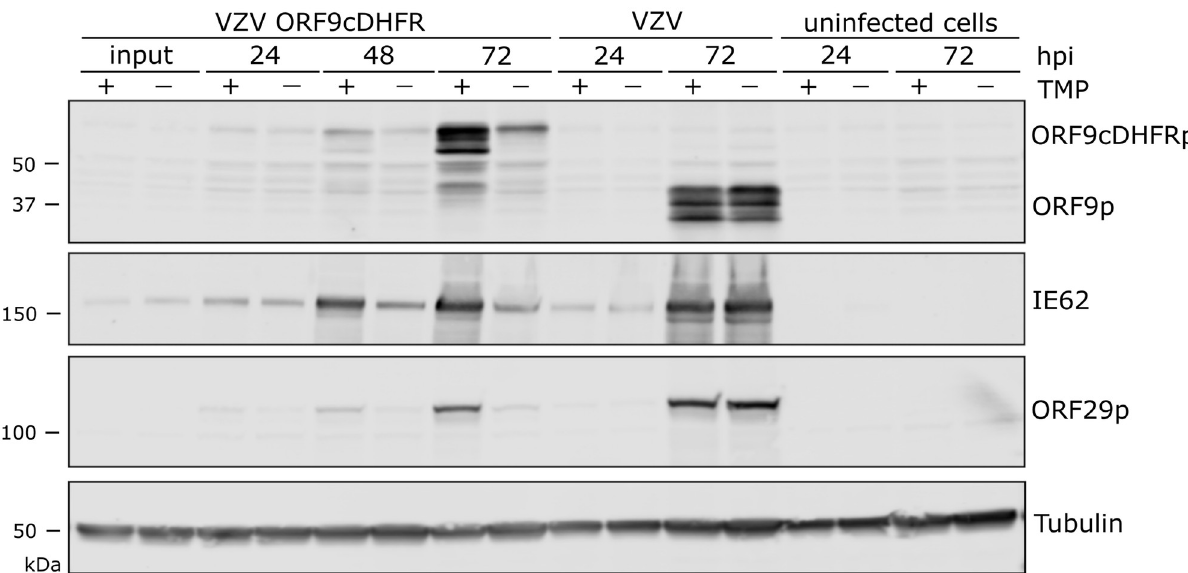
Fig 3. Proteins produced by VZV ORF9cDHFR and pOka grown under media containing or without TMP. (A) Cells were infected with titrated virus infected cell stocks as detailed in methods to allow multi-step virus growth analysis with VZV ORF9cDHFR or pOka. Proteins in infected cultures were harvested at times 24, 48 or 72-hpi in the presence (+) and absence (-) of 100 nM trimethoprim (TMP) and compared to uninfected cell extracts. SDS PAGE separated proteins were immunoblotted and probed with antibodies to ORF9, or proteins from other herpesvirus kinetic classes (IE62, ORF29p), and a cellular control (alpha-tubulin). Signals were determined using a LICOR Odyssey IR imager. ORF9 shows multiple species due to several recognized phosphorylated forms, and the expected size increase (~18 kDa) due to degron motif addition. The sizes of marker proteins (kDa) are indicated to the left of the respective blots. The blots are scanned in linear range and are representative of two identical experiments.